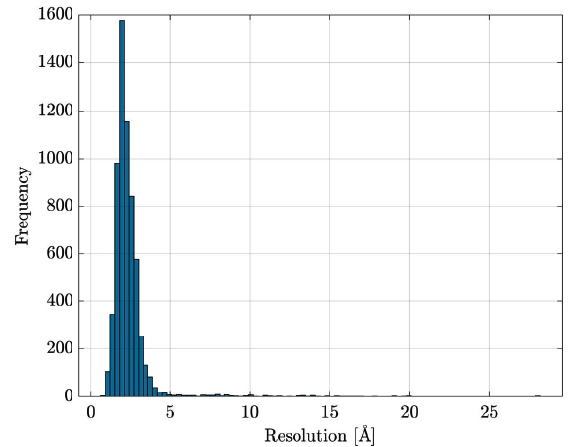
Figure 2. Resolution distribution within the initial 6685 proteins set. Proteins with no resolution information are not considered.